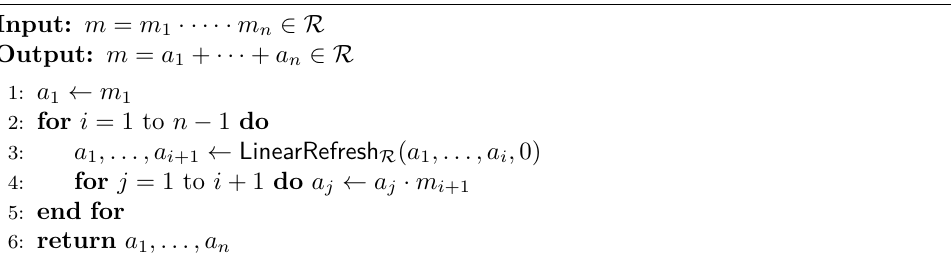
Algorithm 13 Multiplicative to additive conversion ( M2A